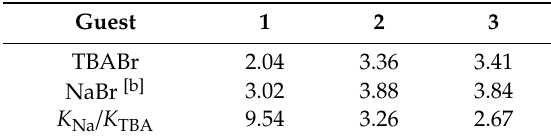
Table 2. Association constants (log K a ) for the interaction between receptors 1 – 3 with TBABr in the absence or presence of one equivalent of NaClO 4 [a] .